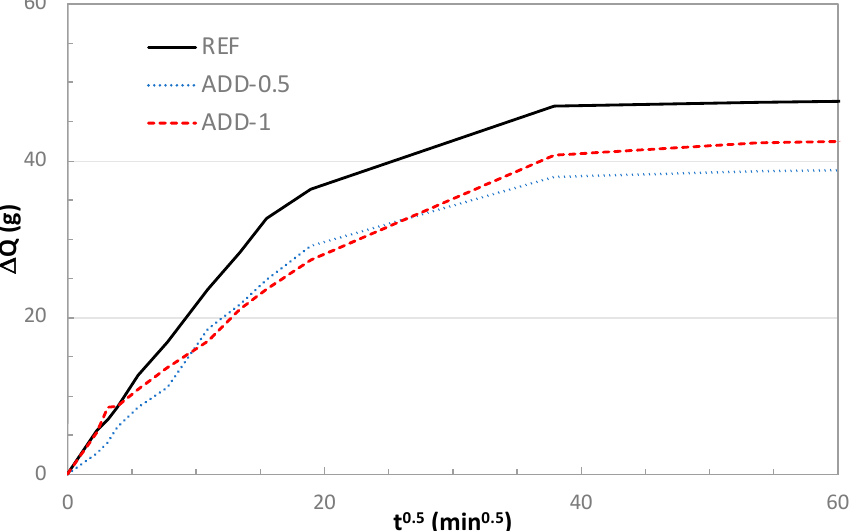
Figure 12. Water capillary absorption test in mortars after 7 days of hardening under high-humidity conditions (>98% RH).